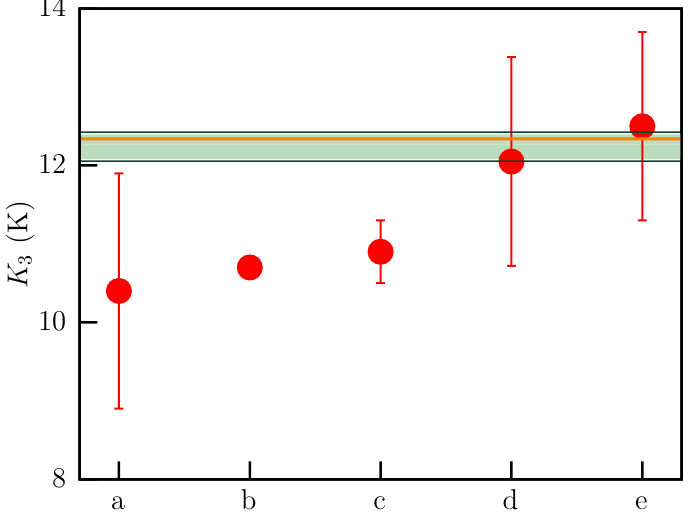
Figure 9: Ground state kinetic energy per atom of liquid 3 He. The horizontal line within the shaded area corresponds to the FN-PIGS estimate; the statistical error is smaller than the line width. The width of the shaded area represents the span of the theoretical estimates in Refs. [ 92, 103–105 ] and their uncertainties. Circles are experimental data from the measured momentum distribution for the